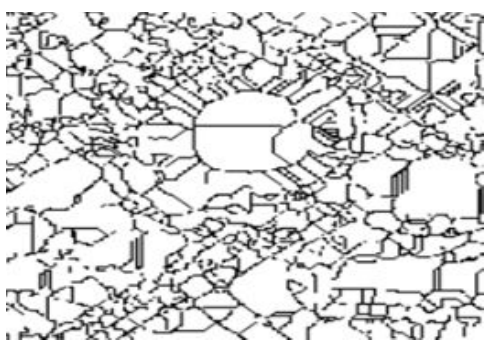
Figure 12. Original watershed segmentation